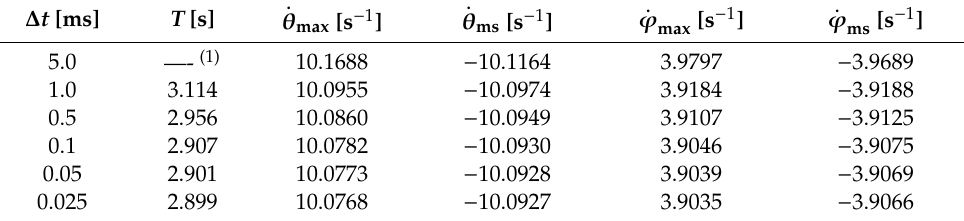
Table 4. Bell 1 ringing right. Convergence test for the simplified